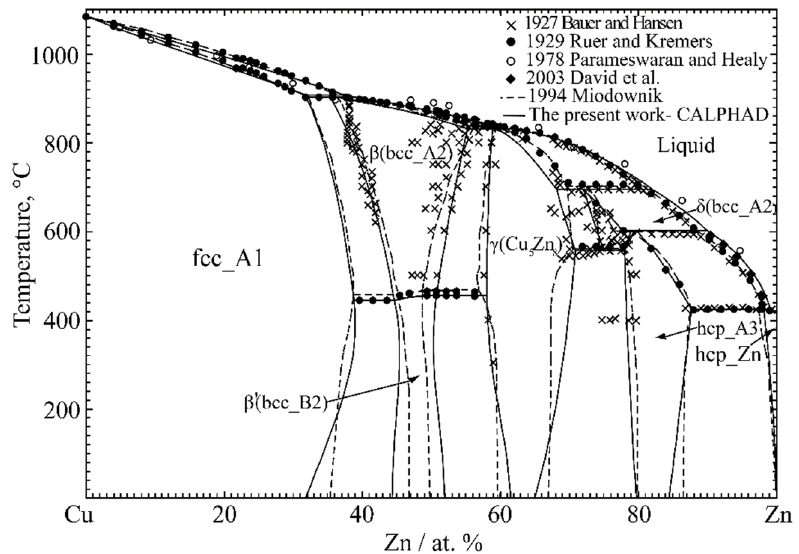
Figure 1. The calculated phase diagram of the Cu-Zn system compared with the experimental data from refs. [36,37,43,58].